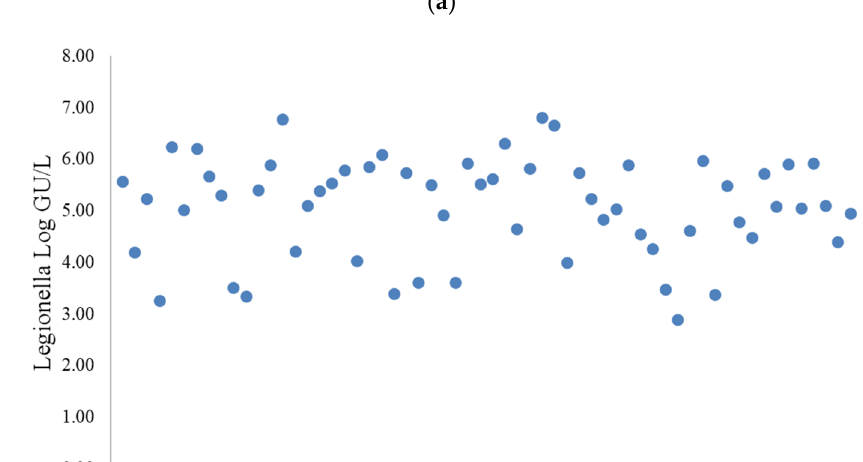
Table 2. Quantification of Legionella in the six culture-positive environmental water samples: comparison of the results obtained using the PMA-qPCR and culture methods and the TVCs.